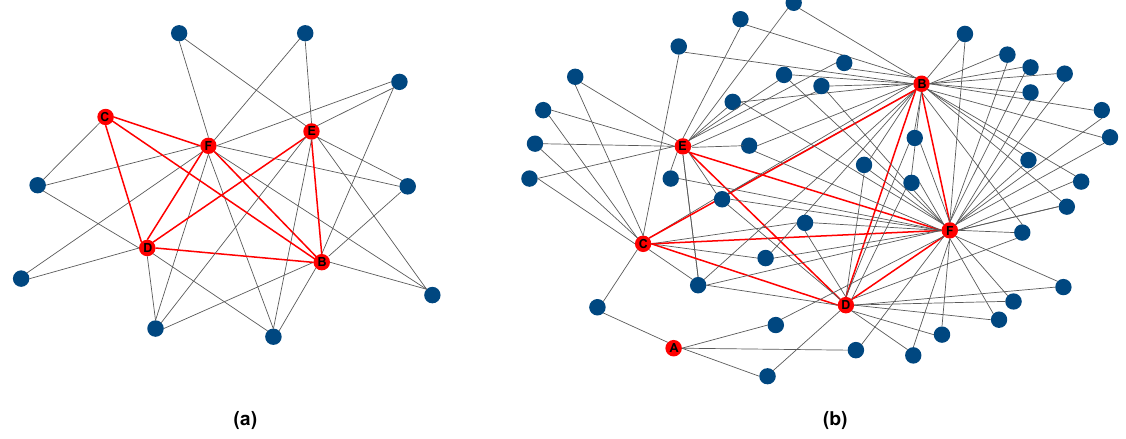
Figure 2. Sharing of alters among the interviewed farms at T0 ( a ) and T1 ( b ). Circles represent the nodes. The red circles are the egos (the interviewed farms), and the blue circles represent the alters. Lines represent the links connecting the pairs of nodes. The red lines represent links between the interviewed farms.